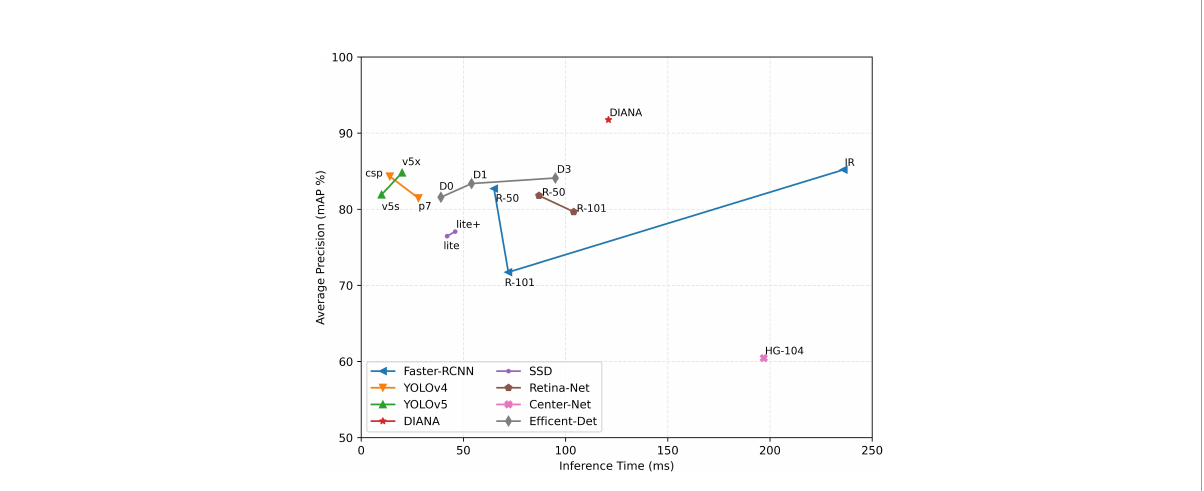
FIGURE 15 Inference time vs. model accuracy (mAP): all values are calculated using the same setup under the same conditions. Time is calculated in milliseconds (ms), and average precision is Pascal VOC style mAP at the 0.5 IoU